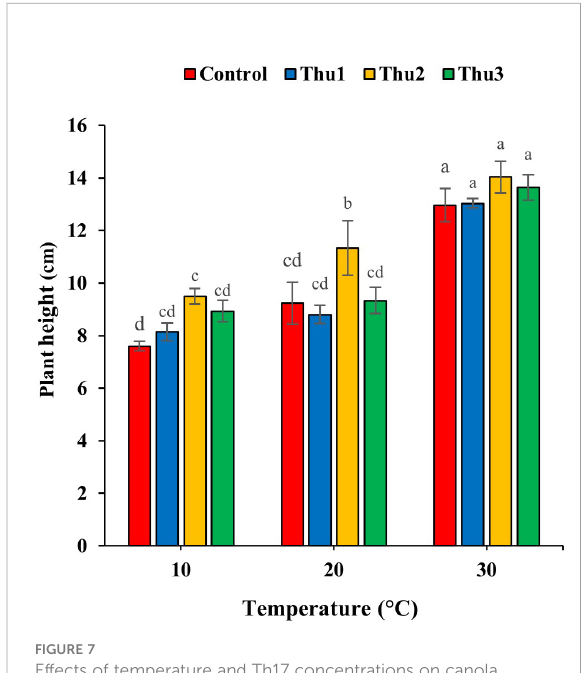
FIGURE 7 Effects of temperature and Th17 concentrations on canola height. Thu1: 10 -7 M Th17, Thu2: 10 -9 M Th17, Thu3: 10 -11 M Th17. Each bar represents mean ± standard error (n=8). Means with the same letters are not signi fi cantly different ( p < 0.05).